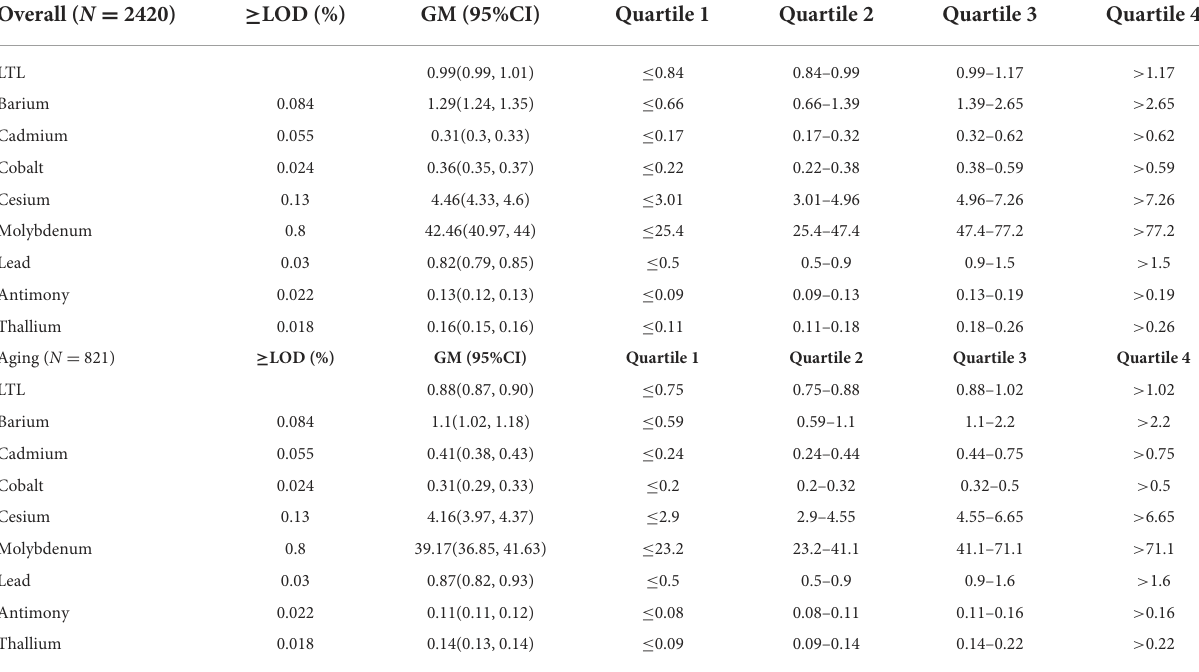
TABLE 2 Urine metals (ng/ml) in overall and aging population of the NHANES